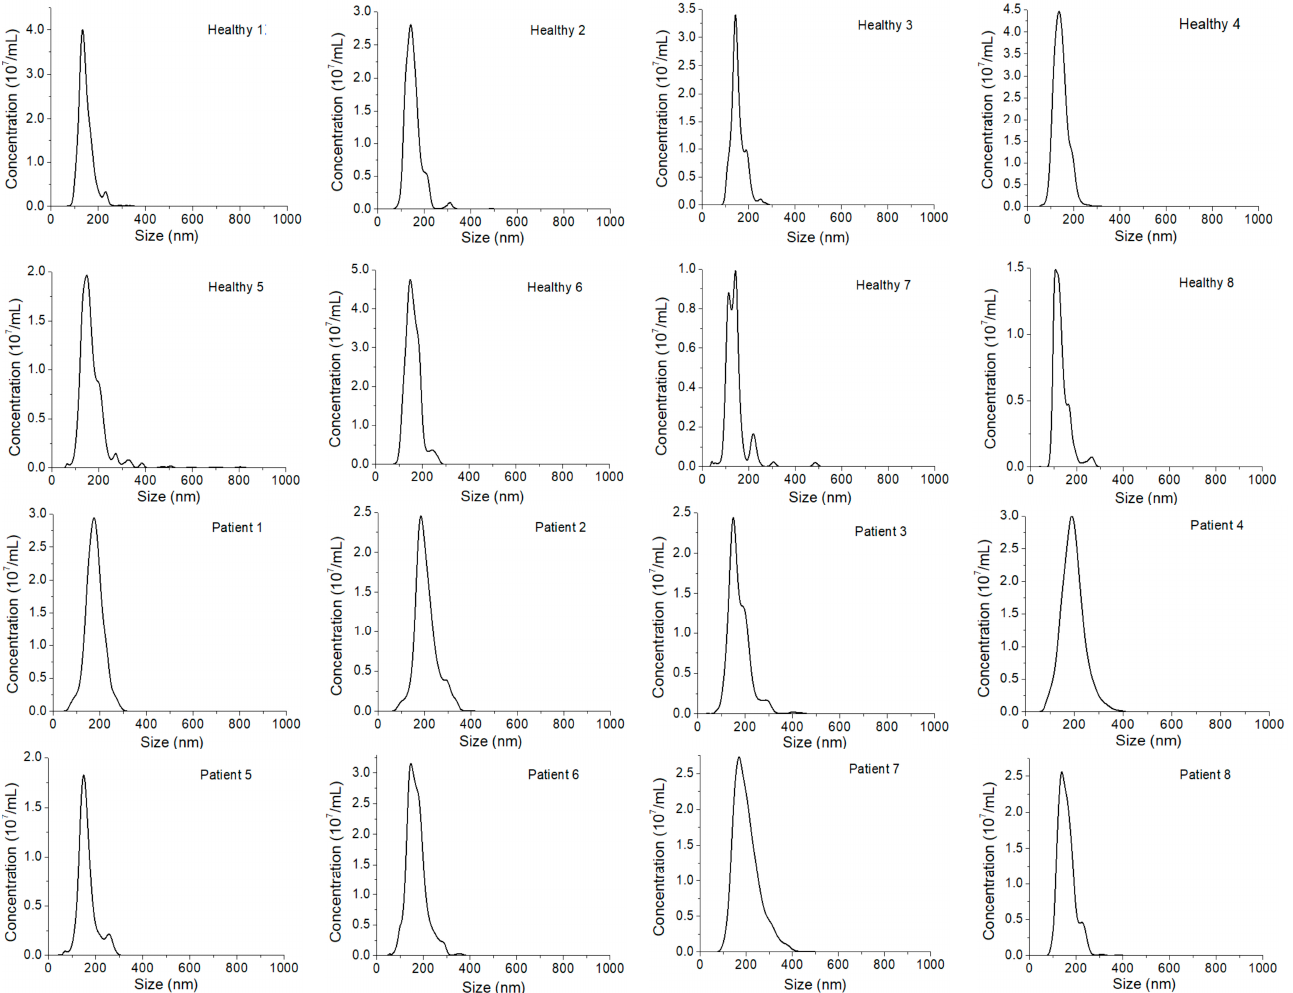
Figure 6. Size distribution of EXOs in plasma from different HER2-positive breast cancer patients (Patient 1 to Patient 8) and different healthy donors (Healthy 1 to Healthy 8) measured by NTA.